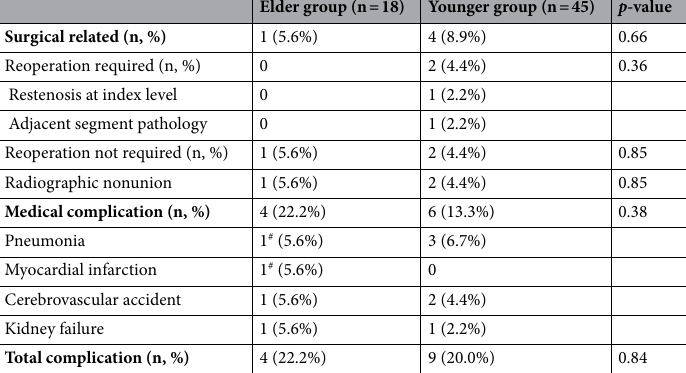
Elder group (n = 18) Younger group (n = 45) p -value Surgical related (n, %)